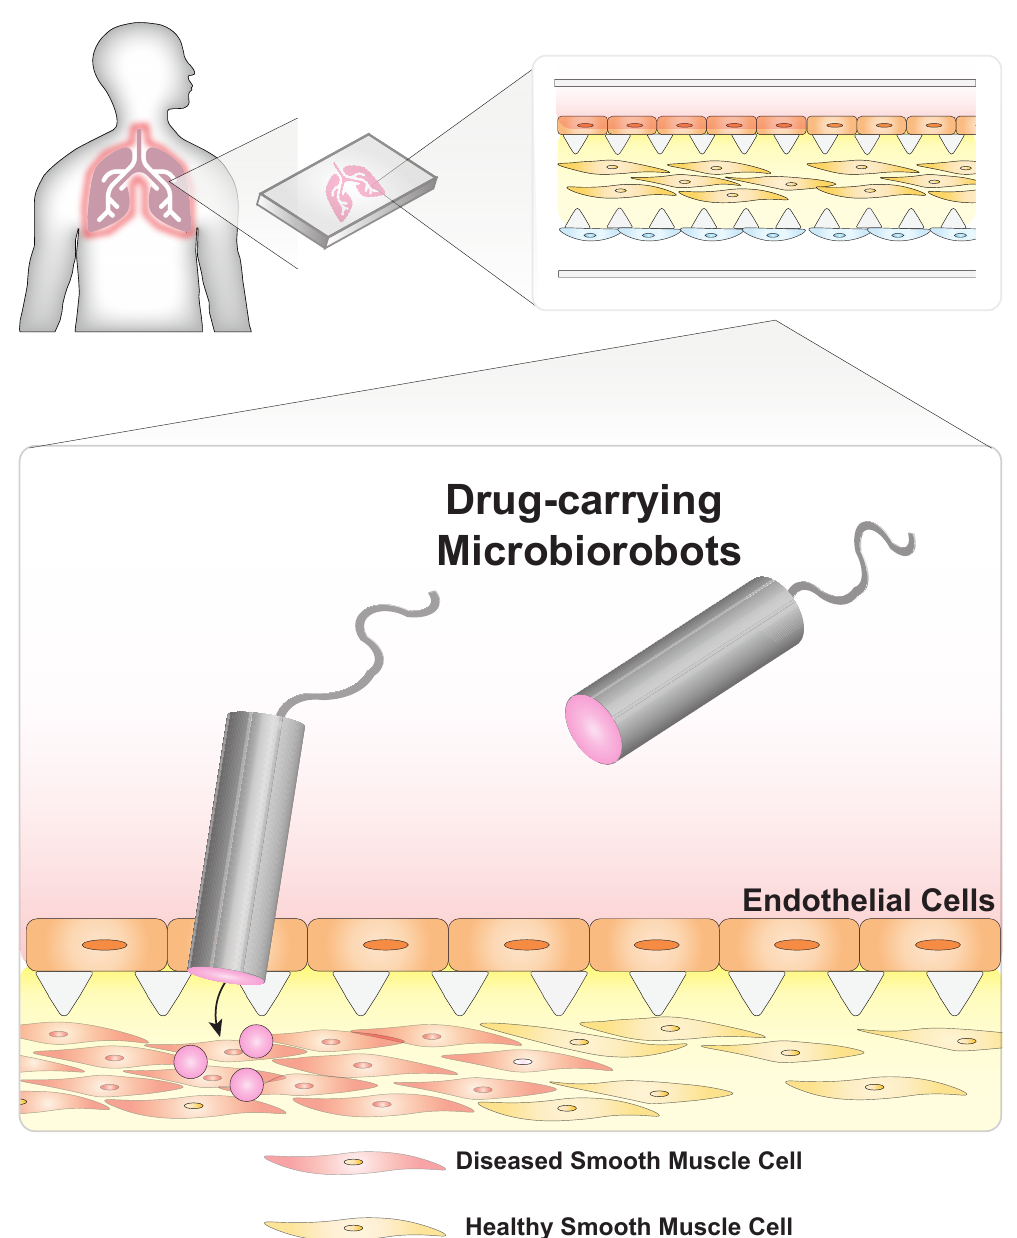
Figure 5. A potential application of MBRs in organs-on-a-chip: treating pulmonary hypertension. The PH-on-a-chip model would incorporate the key cell types (e.g., smooth muscle cells, SMCs) involved in disease progression in an anatomically similar format. For examples, SMCs embedded in extracellular matrix (yellow) could be caged between micropillars (white triangles). This device is inspired by a previously published device used by Schuerle et al. [45]. Next, a magnetically actuated microbiorobot carrying Cpd22, an inhibitor of SMC-driven remodeling [61], could be engineered to maneuver within an endothelialized lumen representing the vasculature. By employing a SMC-sensitive polymer cap [46], the robot would release the inhibitor upon contact with